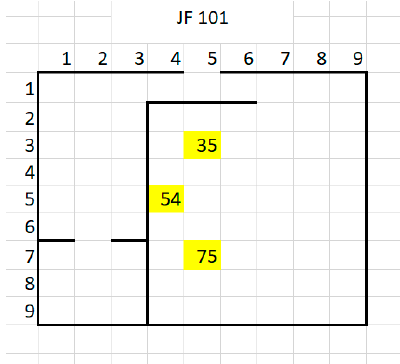
Figure 5. A more schematic representation of the positions where measurement stations were placed (75, 54 and 35 are the marked positions of MeS 1 to MeS 3 ).